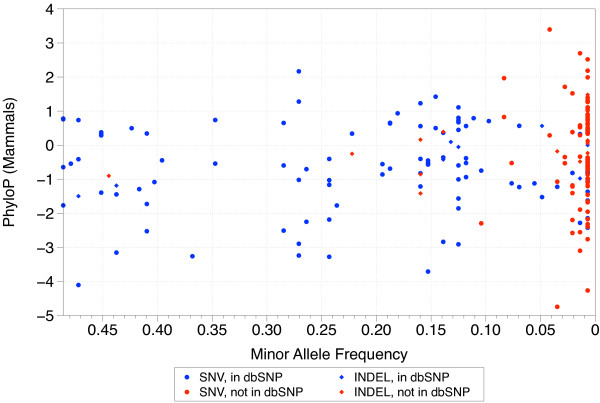
Summary of single nucleotide variants (SNV) and insertions or deletions (indel) variation discovered at theNLGN3andNLGN4Xloci in male individuals with autism spectrum disorder (ASD). The frequency of SNVs and indels (minor alleles) in cases is plotted against their level of evolutionary conservation. Most common variation has already been discovered and exists in public databases (blue; circles and diamonds). Most of the rare variation at both loci was discovered in our study and not contained in public databases (red; circles and diamonds).